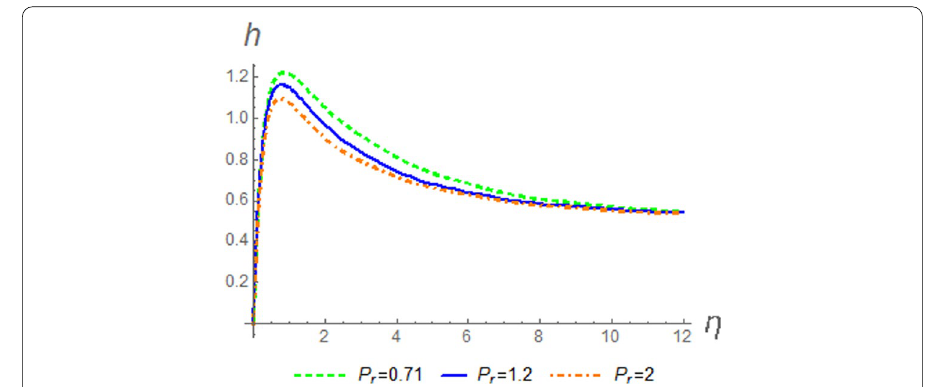
Fig. 10 Effect of P r on the velocity profile